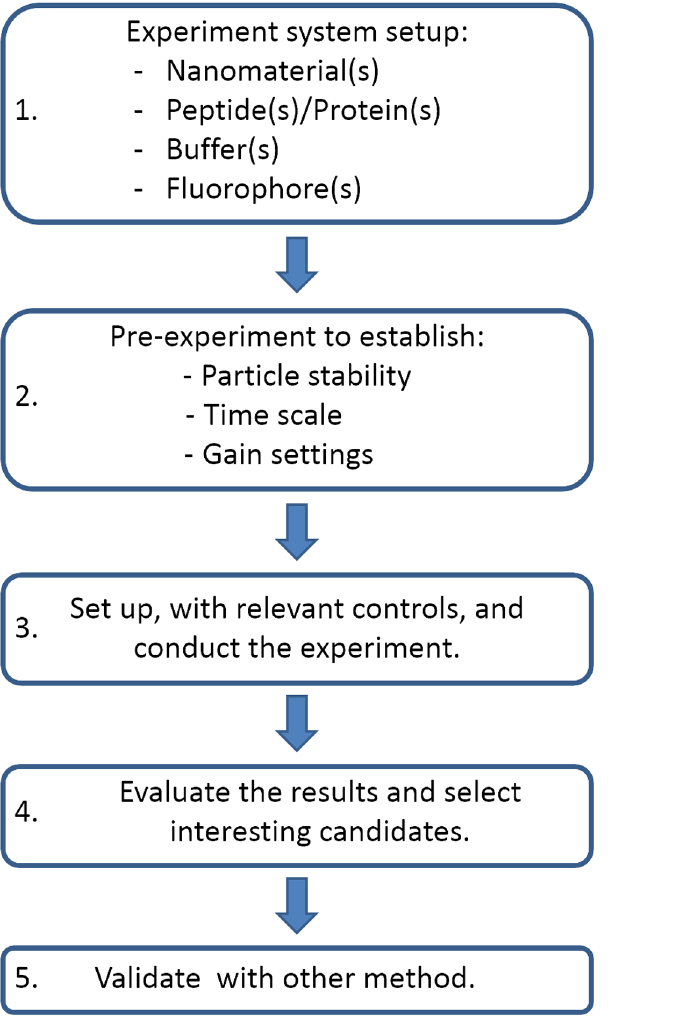
Fig 1. Method outline. Short description of the